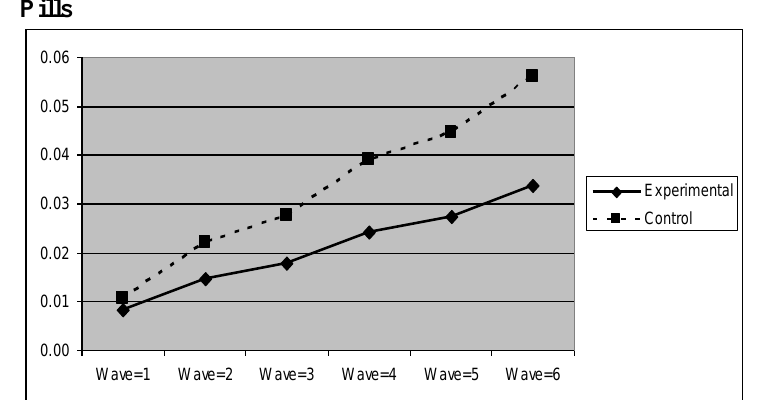
FIGURE 13 . Growth trajectories of the experimental group (Tier 1 participants who perceived the program as effective) and control group using the item score of cannabis use as the outcome indicator.